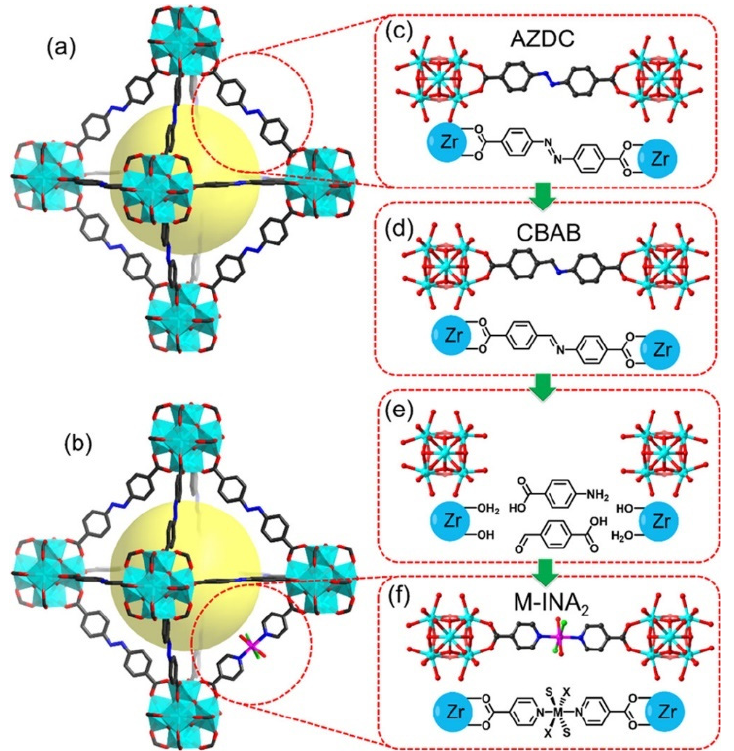
Figure 3. Structure of PCN-160 ( a ) and PCN-160-R%M with trans -chelating ligands ( b ). Transformation of ligand fragment in PCN-160 ( c ) by CBAB exchange ( d ), linker labialization ( e ), and installation of M-INA 2 (INA = isonicotinate) ( f ). These figures are based on respective single-crystal structures after removal of the disordered fragments. Cyan = Zr. Red = O. Grey = C. Blue = N. Adapted with permission from [40]; Published by American Chemical Society, 2018.